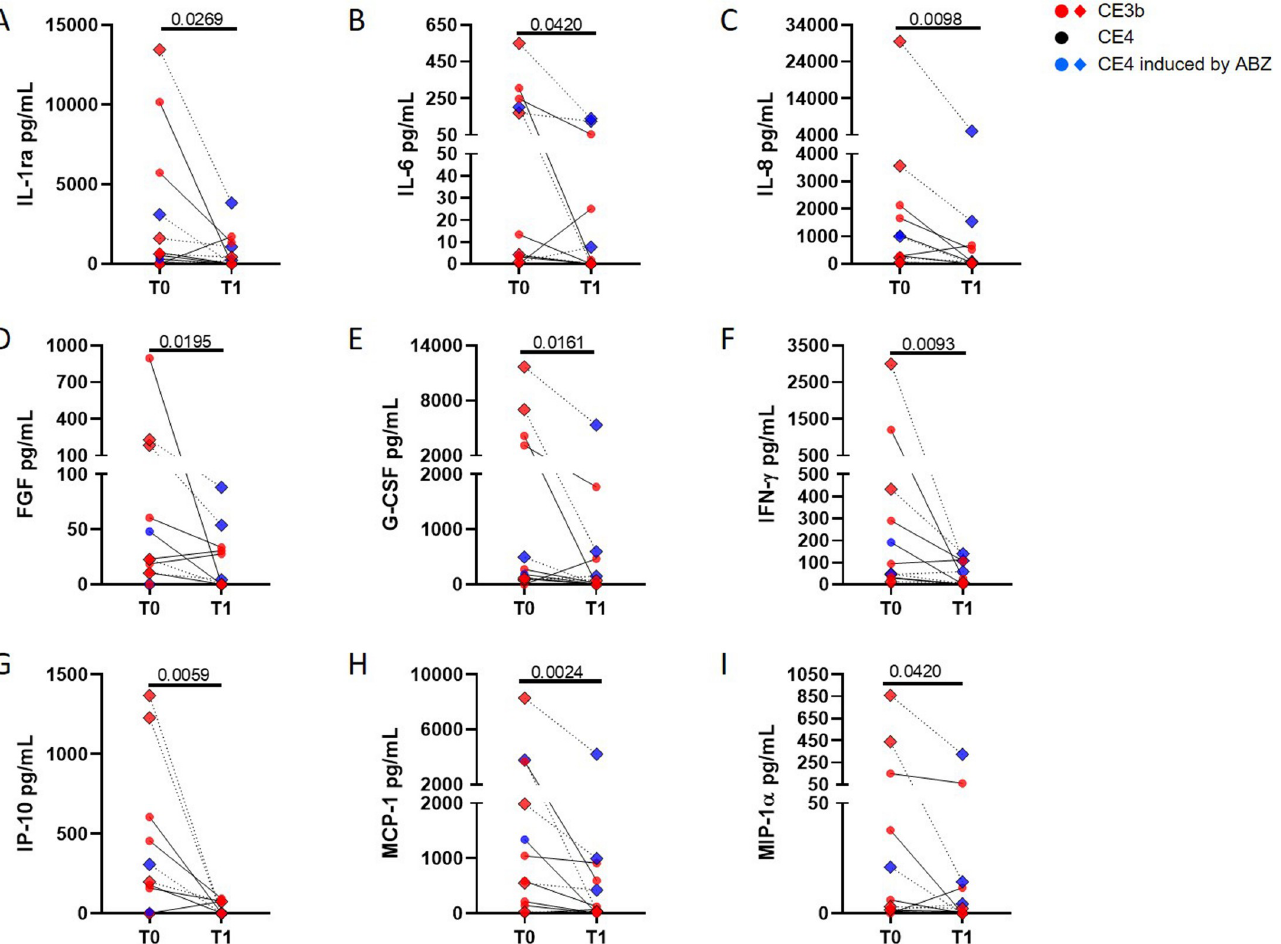
Fig 3. The AgB-specific IL-1ra, IL-6, IL-8, FGF, G-CFS, IFN- γ , MIP-1 α , IP-10 and MCP-1 levels in patients in the CE3b-group are significantly reduced overtime. Multiplex analysis performed in 12 patients per study group. The following soluble factors were evaluated: IL-1 β , IL-1ra, IL-2, IL-4, IL-5, IL-6, IL-7, IL-8, IL-9, IL-10, IL-12p70, IL-13, IL-15, IL-17A, Eotaxin, basic FGF, G-CSF, GM-CSF, IFN- γ , IP-10, MCP-1, MIP-1 α , MIP-1 β , PDGF, RANTES, TNF- α , VEGF. In patients in the CE3b-group a significant decrease of IL-1ra ( A ), IL-6 ( B ), IL-8 ( C ), FGF ( D ), G-CSF ( E ), IFN- γ ( F ), IP-10 ( G ), MCP-1 ( H ) and MIP-1 α ( I ) at T1 compared to T0 was observed. Footnotes: Analytes concentrations were determined by luminex. Responses in all the panels were compared using the Wilcoxon test; differences were considered significant at p-values of � 0.05. Red dots indicate patients with CE3b cysts, blue dots indicate patients with treatment-induced CE4 cysts, black dots indicate patients with spontaneously-inactivated cysts, diamond symbols indicate that the patient received albendazole. The continuous lines indicate that no treatment was administered; dotted lines indicate albendazole between the 2 time points. IL: Interleukin; ra: receptor antagonist; G-CSF: granulocyte-colony stimulating factor; IFN: Interferon; IP-10: IFN- γ -induced protein-10; MCP: monocyte chemoattractant protein; FGF: fibroblast growth factor; MIP: macrophage inflammatory protein.